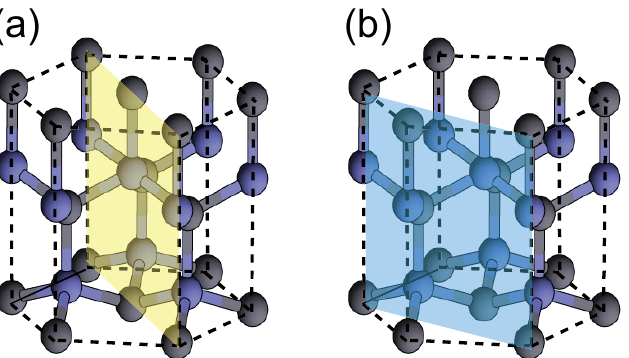
Figure 11. Schematics of crystal planes with nonpolar ( a ) (cid:4666)11(cid:3364)00(cid:4667) and ( b ) (cid:4666)112(cid:3364)0(cid:4667) orientations.